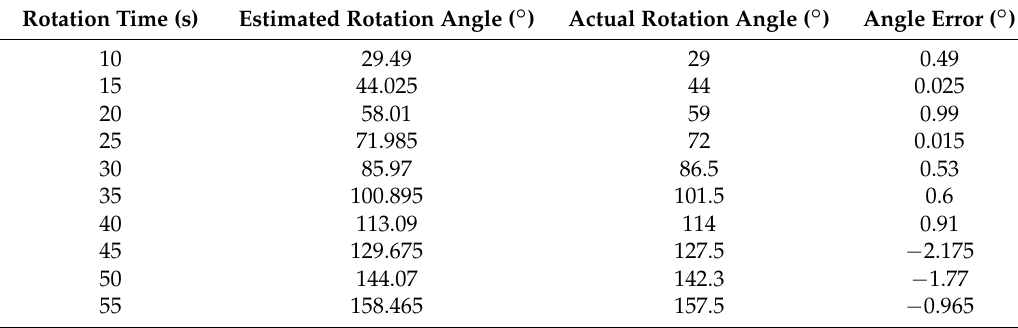
Table 6. Comparison of rotation angle after